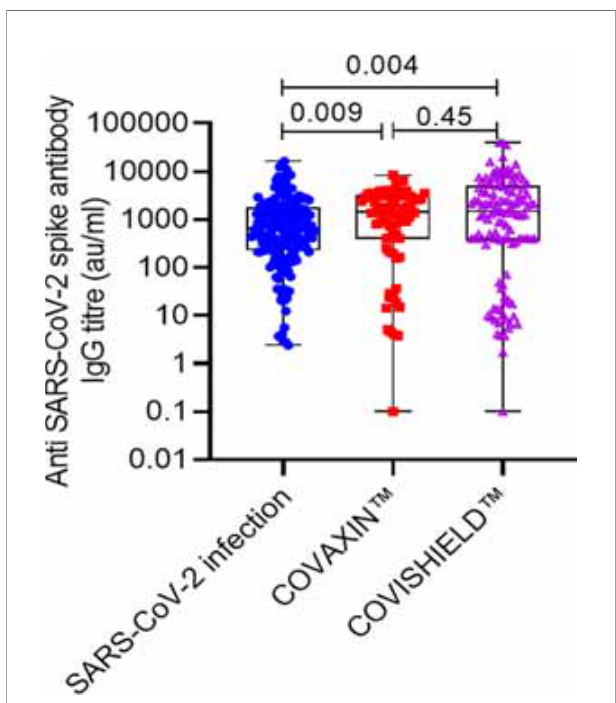
FIGURE 1 | Anti-SARS-CoV-2 spike protein antibody titer in RTRs infected with SARS-CoV-2 or vaccinated with 2 doses of either COVISHIELD ™ or COVAXIN ™